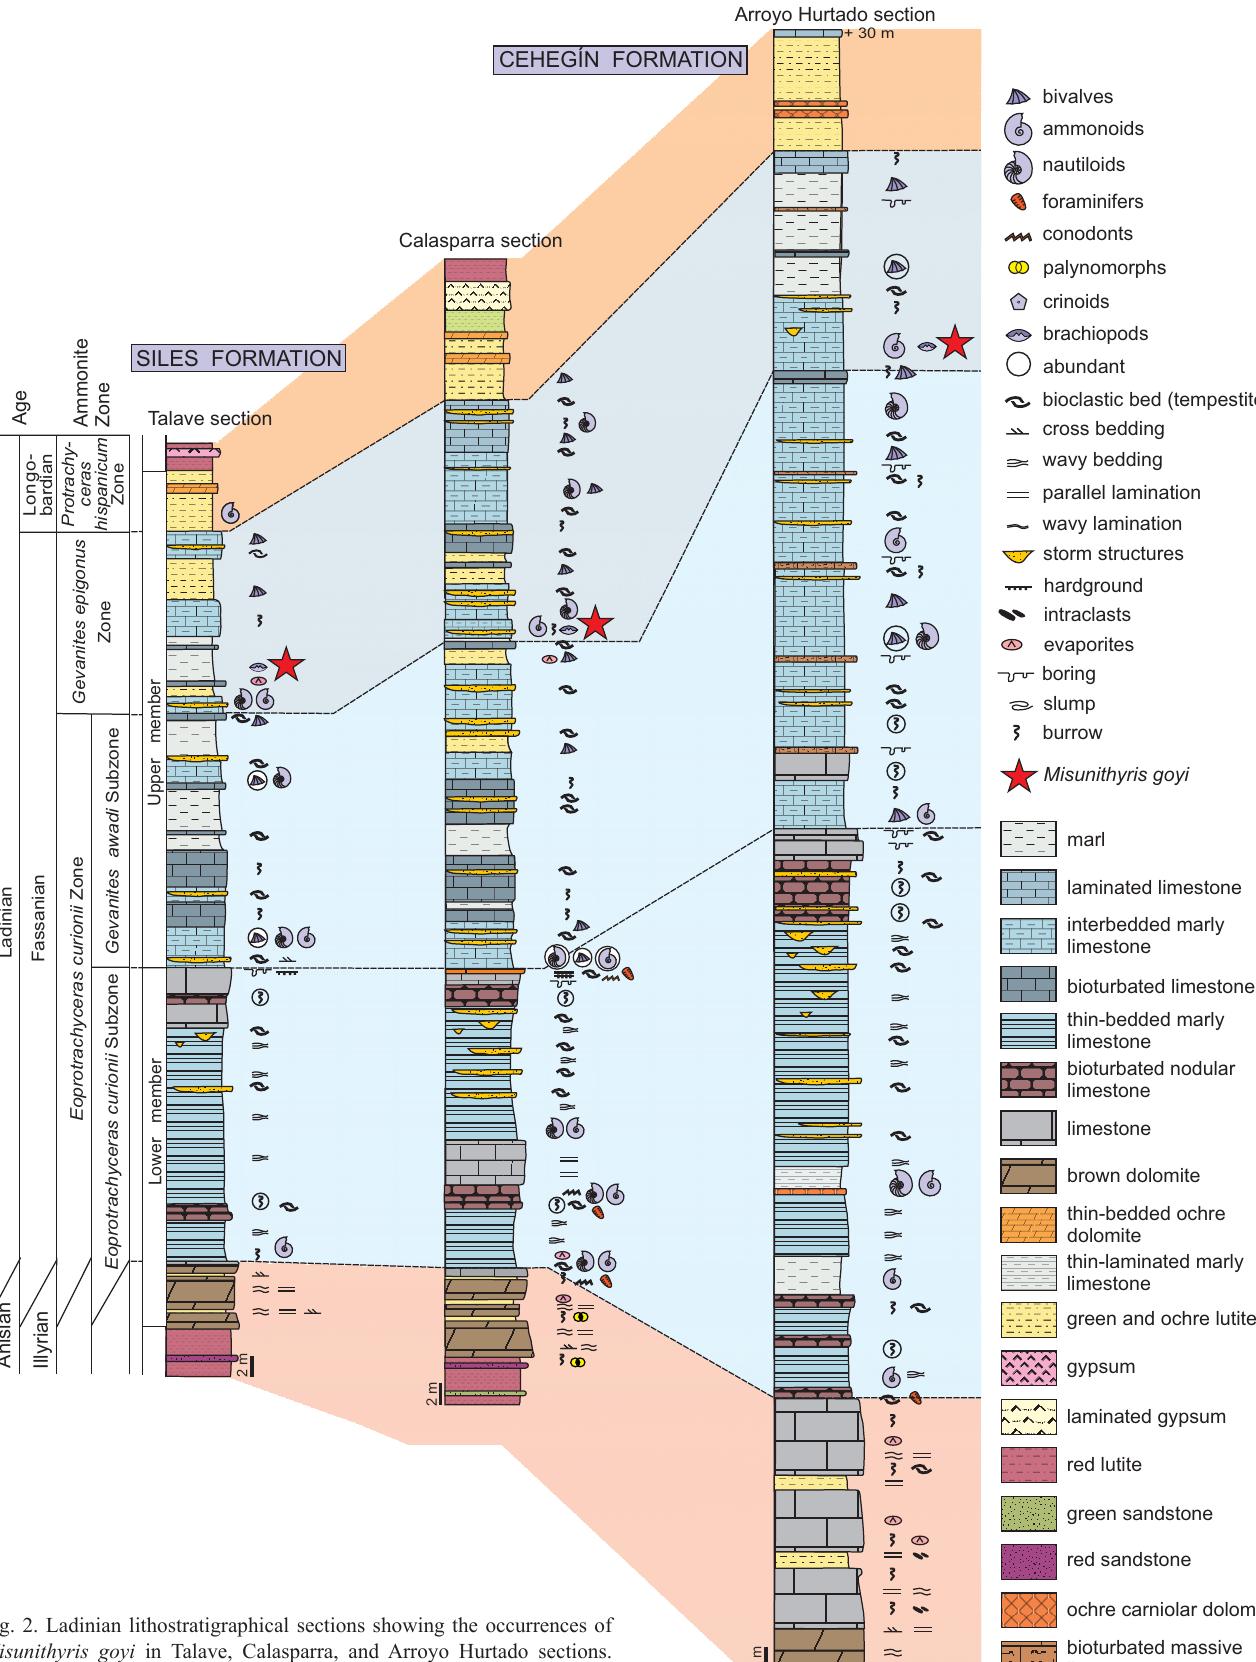
Fig. 2. Ladinian lithostratigraphical sections showing the occurrences of Misunithyris goyi in Talave, Calasparra, and Arroyo Hurtado sections. Ammonite zones and subzones after Pérez-Valera